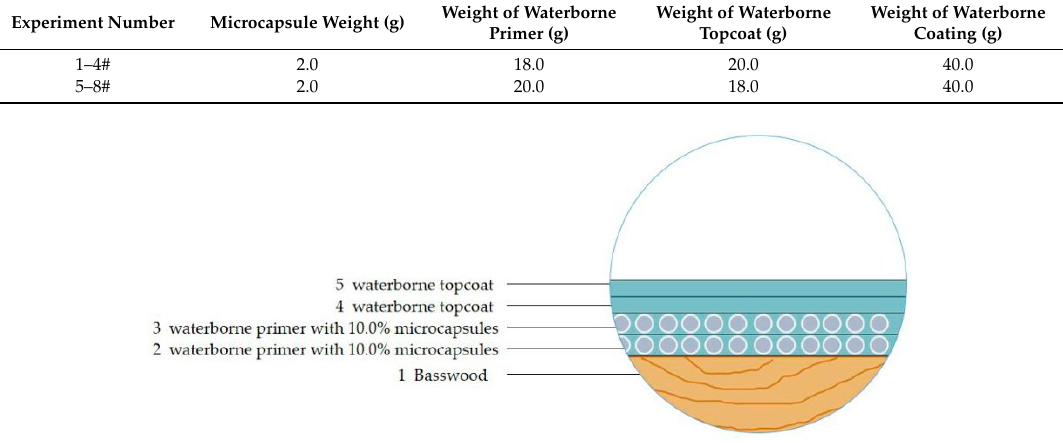
Figure 1. A schematic of sample 1. Table 1. Experimental schedule of coating process of the waterborne acrylic coatings with microcapsules.